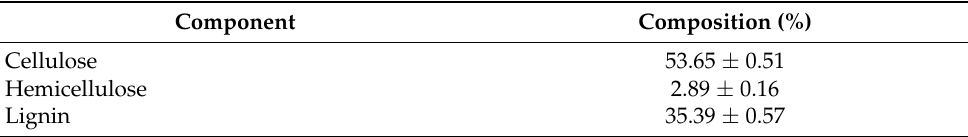
Table 2. Chemical composition of autohydrolyzed agave bagasse at optimal conditions (expressed as percentage by dry material